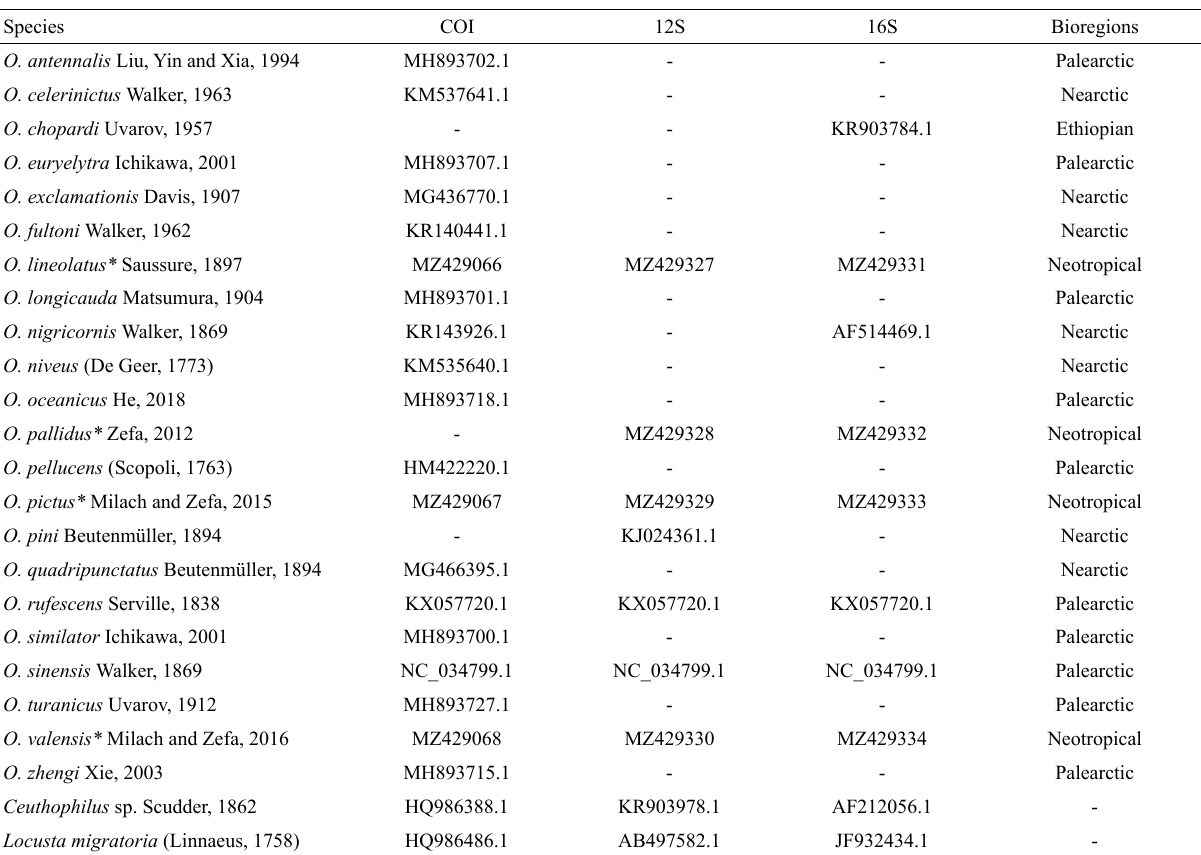
*Sequences generated in the present study. (-) Missing